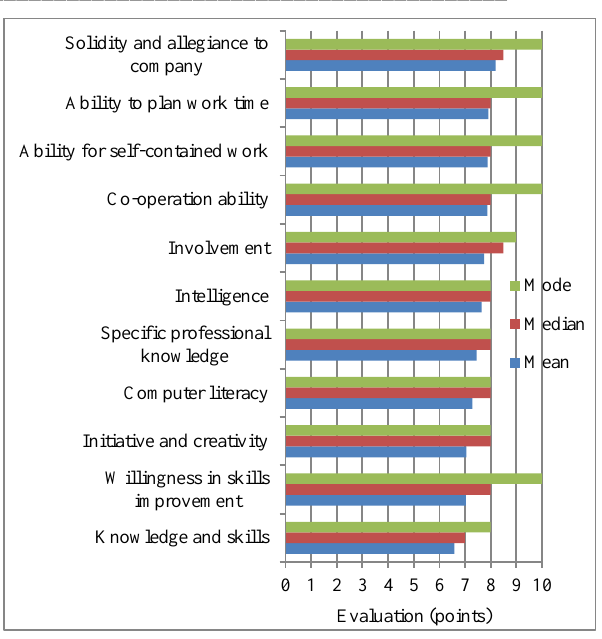
Fig. 1. Average (mean, median and mode) indicators of employers’ evaluation of employees’ skills and attitudes. Those are important when hiring new employees. Source: compiled by authors based on the employers’ survey, 2013 ( n = 336). Evaluation scale 1–10, where 1 – unimportant; 10 – extremely important.